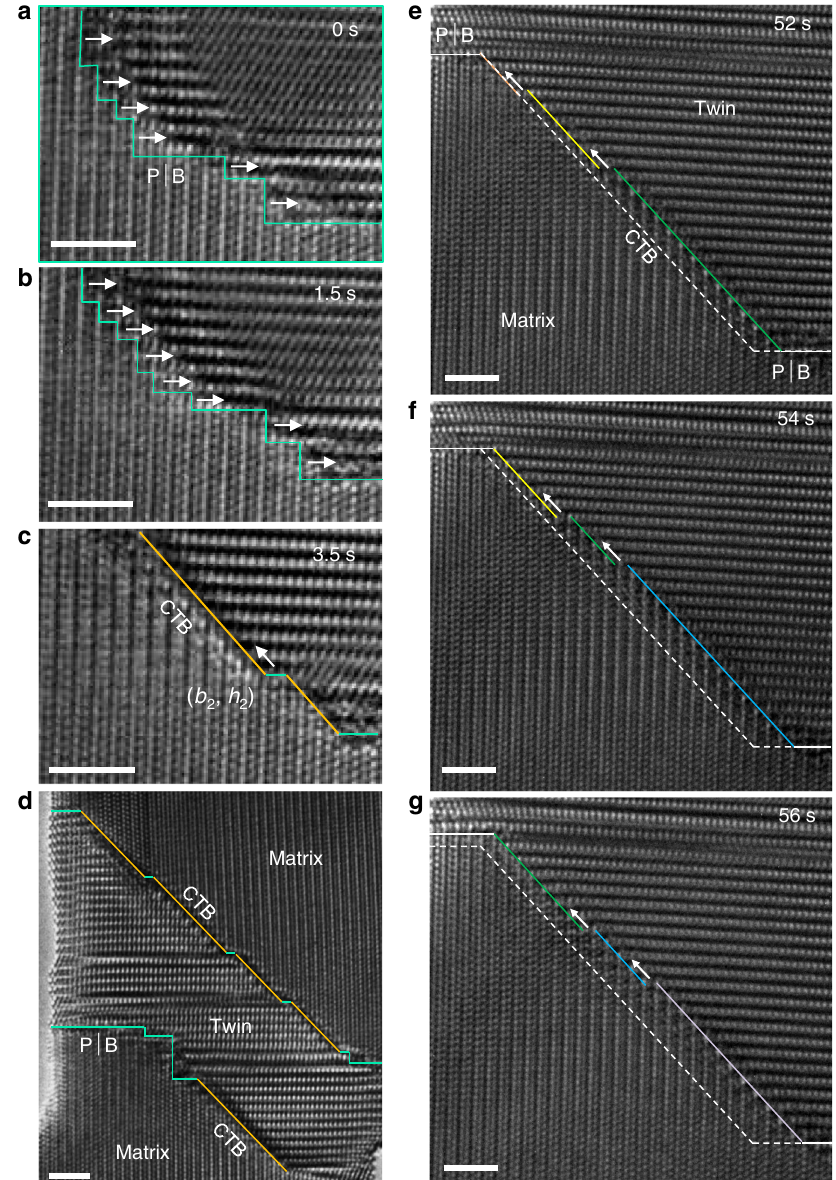
Fig. 4 Twin boundary transformation from P │ B interfaces to CTB during detwinning. a – c Sequential HRTEM snapshots of the process. The dominant defects in the twinning transit from disconnections on P │ B interfaces to twinning dislocations ( b 2 , h 2 ) on CTB. Zig-zag turquoise lines indicate the P │ B interfaces. White arrows in a , b indicate the moving directions of the disconnections on the P │ B interface. d Overview of the twin upon partial detwinning, showing serrated twin boundaries. e – g Sequential HRTEM snapshots showing CTB propagation by twinning dislocations. White dash line is a reference line to show the migration of the CTBs (colored lines). Arrows in c , e – g indicate the migration direction of the twinning dislocations. Scale bars in a – g , 2